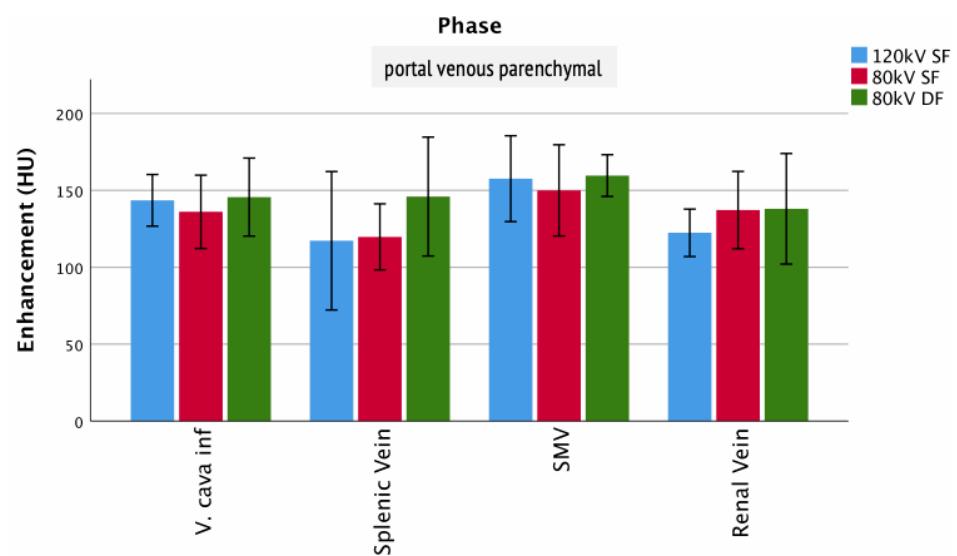
Figure 8. Enhancement of veins. Columns show the enhancement of veins for the different injection protocols in hepatic phase.